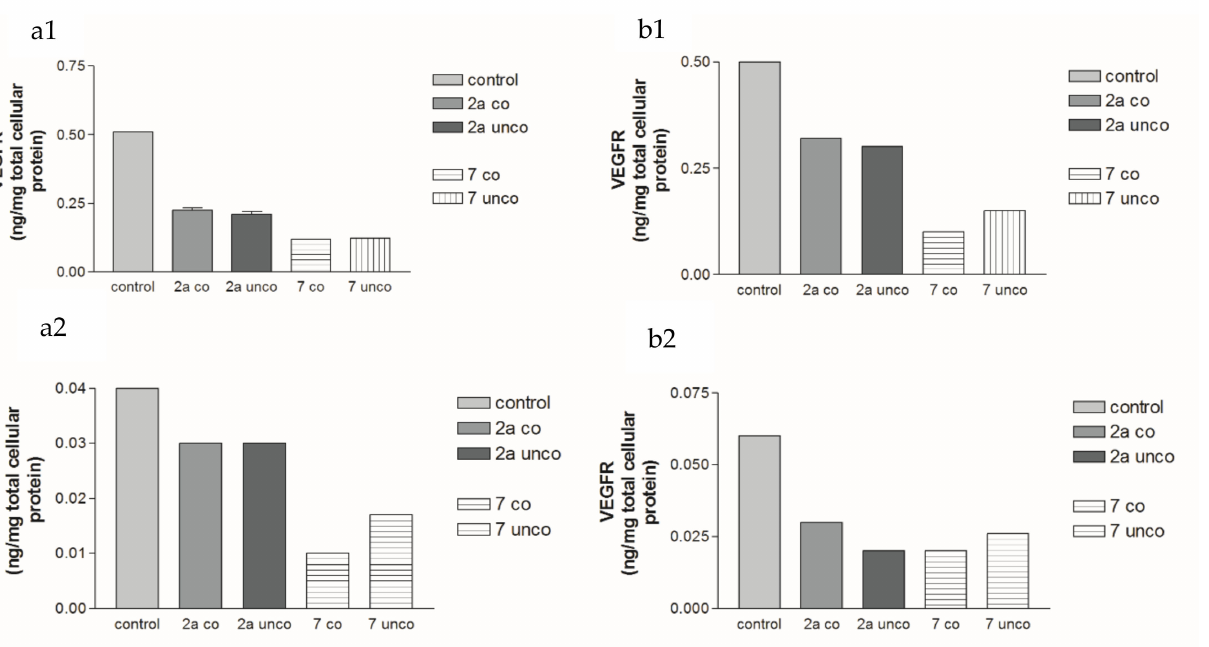
Figure 22. Effects of 2a - and 7 -loaded niosomes (F2 and S2) either coated with TPGS versus the uncoated ones on VEGFR protein expression level (ng/mg tissue protein) in HEPG2 and MCF-7, where ( a1 , a2 ) at 24 h and ( b1 , b2 ) 72 h, all therapies were provided for 3 successive days. Results are given as mean ± S.E.M. 2a co: 2a -coated (F2), 2a unco: 2a uncoated (F2), 7 co : 7 -coated (S2), 7 unco: 7 uncoated